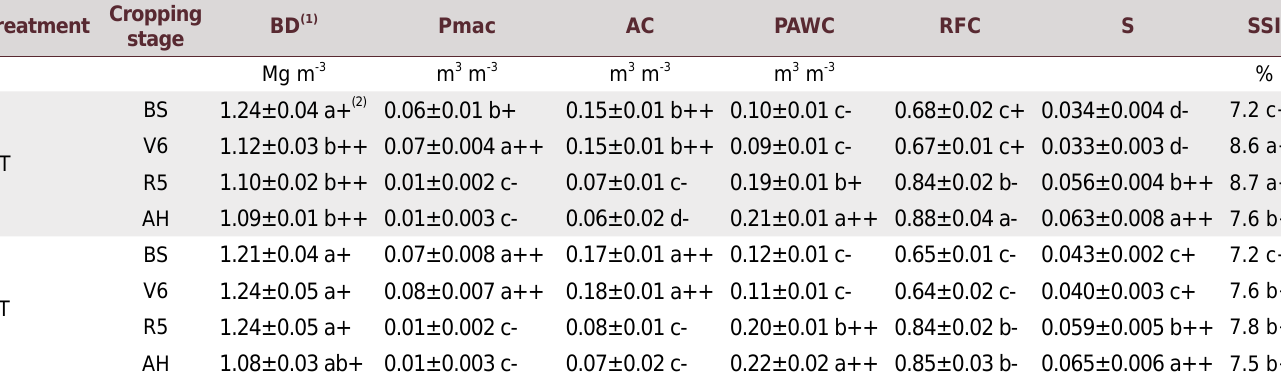
Table 2. Capacity SPQ indicators (mean values ± standard deviations) for the different treatments (NT and CT) and cropping stages of the corn growing season (BS, V6, R5, and AH) Cropping Treatment